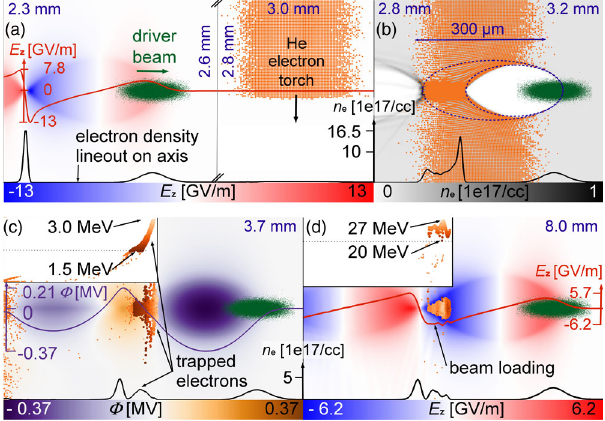
FIG. 4. Plasma torch injection in case (iii). In preionized hydrogen, at gas densities of n pronounced blowout is generated (a) and the tunable helium torch (b) downramp leads to dark-current free witness bunch formation (c) and allows for massive charge at substantially beam-loaded levels